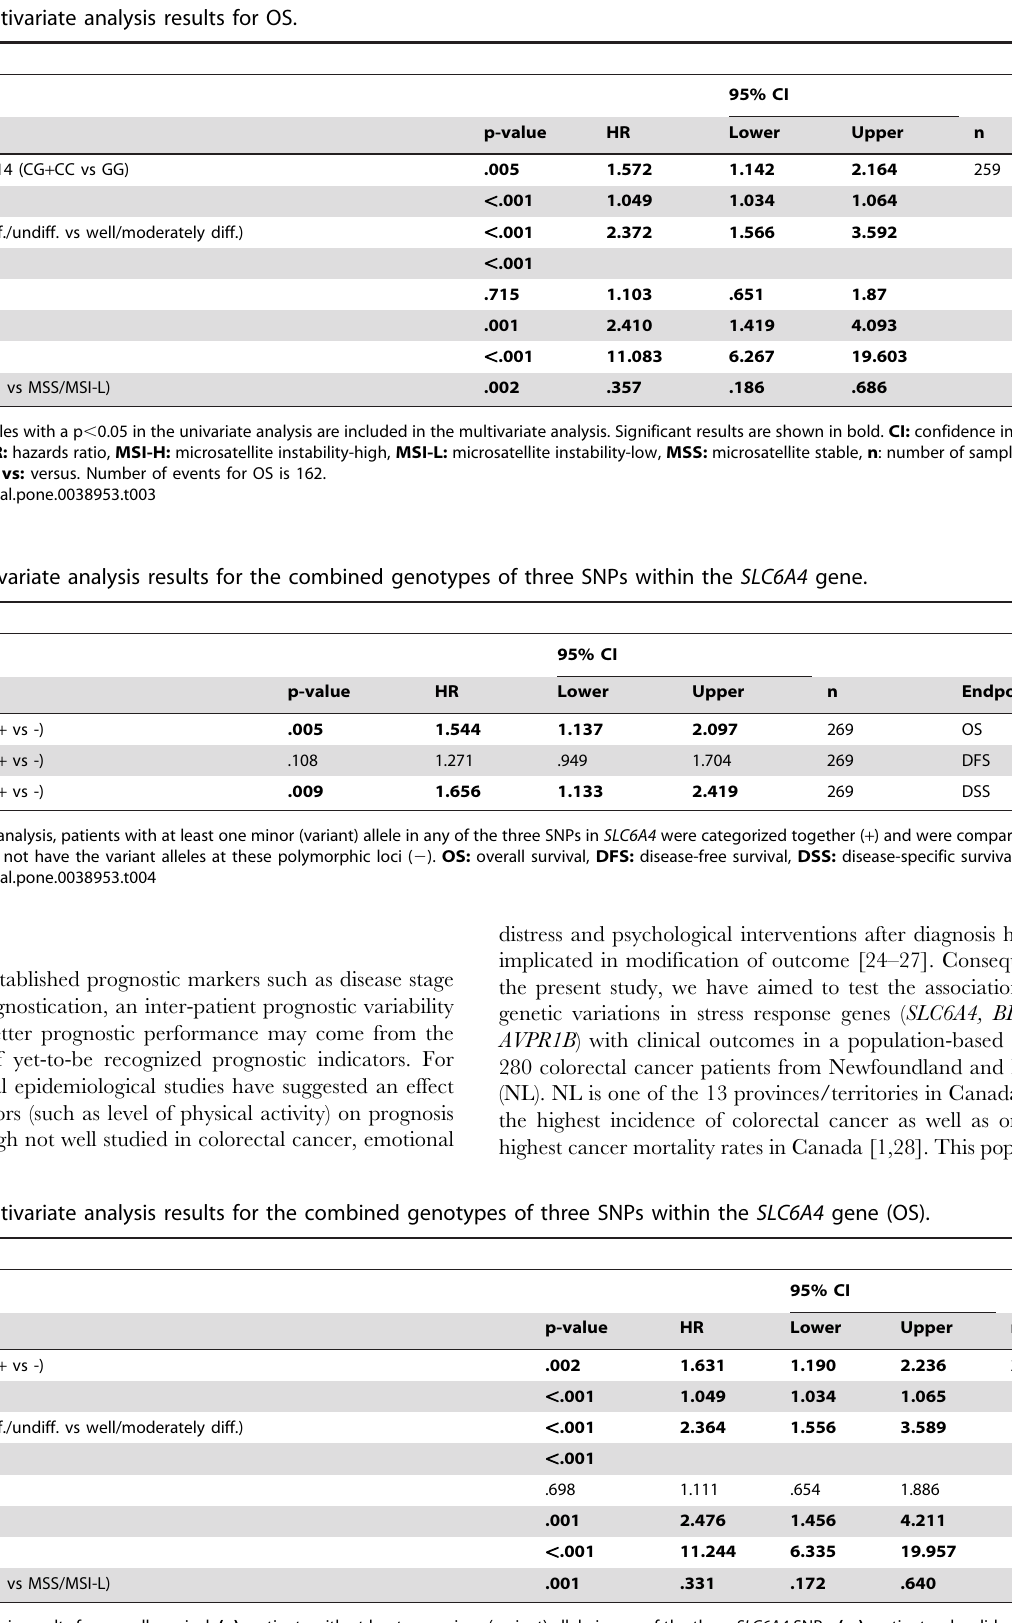
Table 3. Multivariate analysis results for